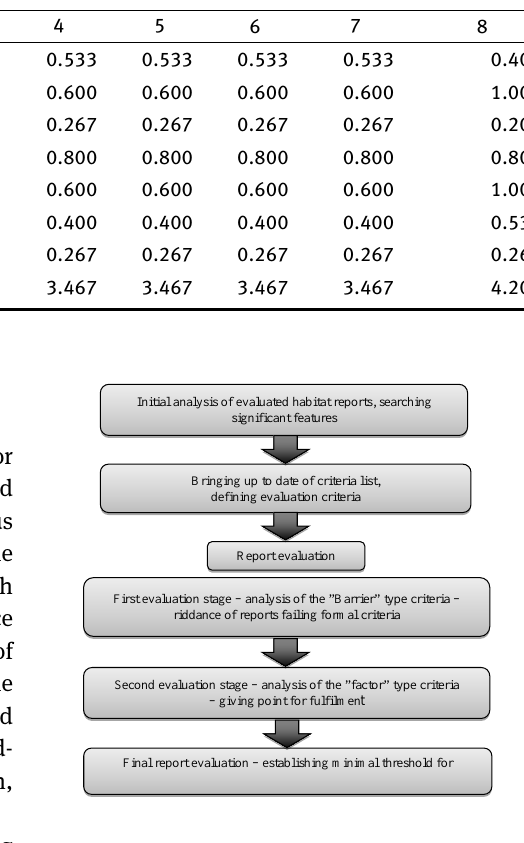
Table 5: The evaluation of reports with the weight-point method. No of criterion